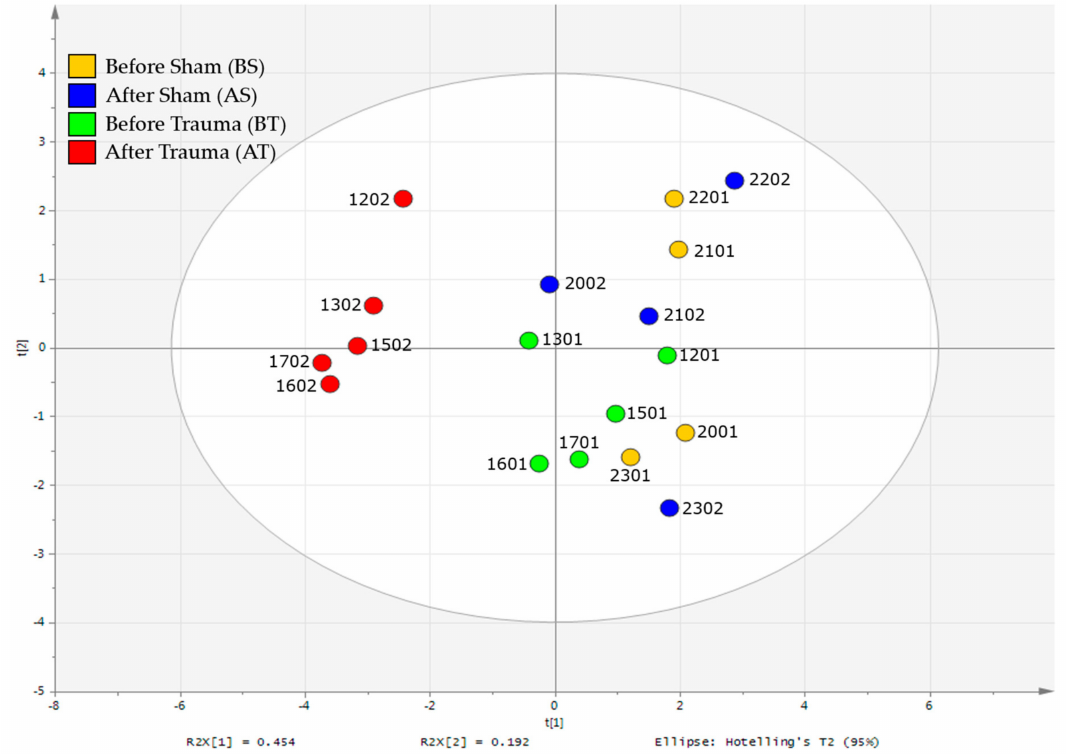
Figure 2. Principal component analysis (PCA) score plot of the untargeted binning NMR data. Samples from pigs before and after the sham procedure are colored yellow and blue, respectively. Samples from pigs before and after trauma injury are colored green (BT) and red (AT). For the sample IDs, the first two digits denote the pig ID followed by the timepoint at which the blood was drawn: (01)—before trauma / sham and (02)—after trauma / sham. Model variation (R2X) represents the fraction / percentage of the variation of the model X explained by component